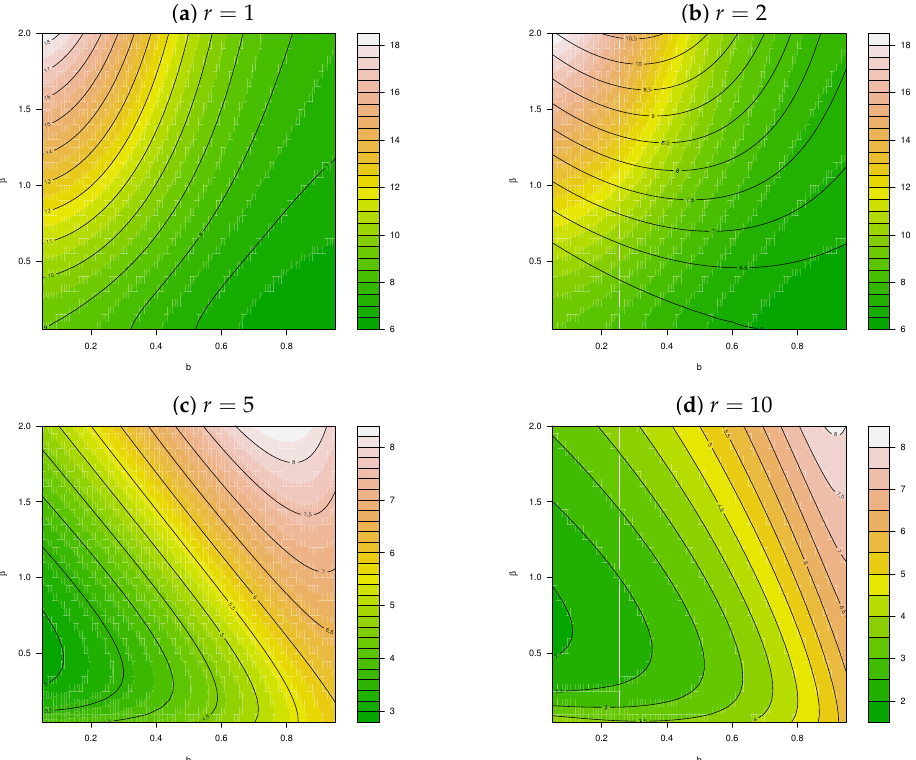
Figure 4. Kurtosis for Y ∼ ncLII ( β , b , r ) for different values of ( β , b ) and r =